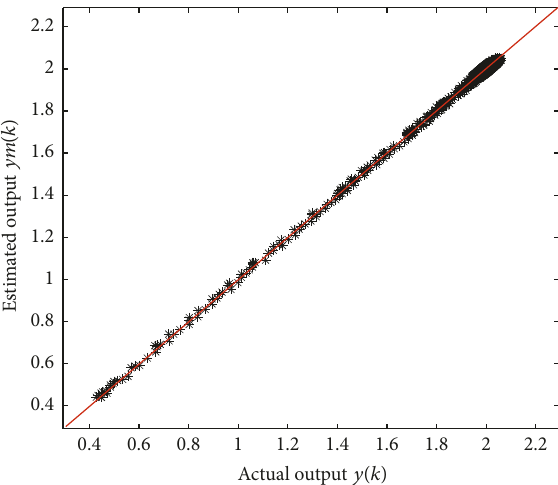
Figure 11: Comparison between 𝑦(𝑘) and its estimate, 𝑦 𝑚 (𝑘) .